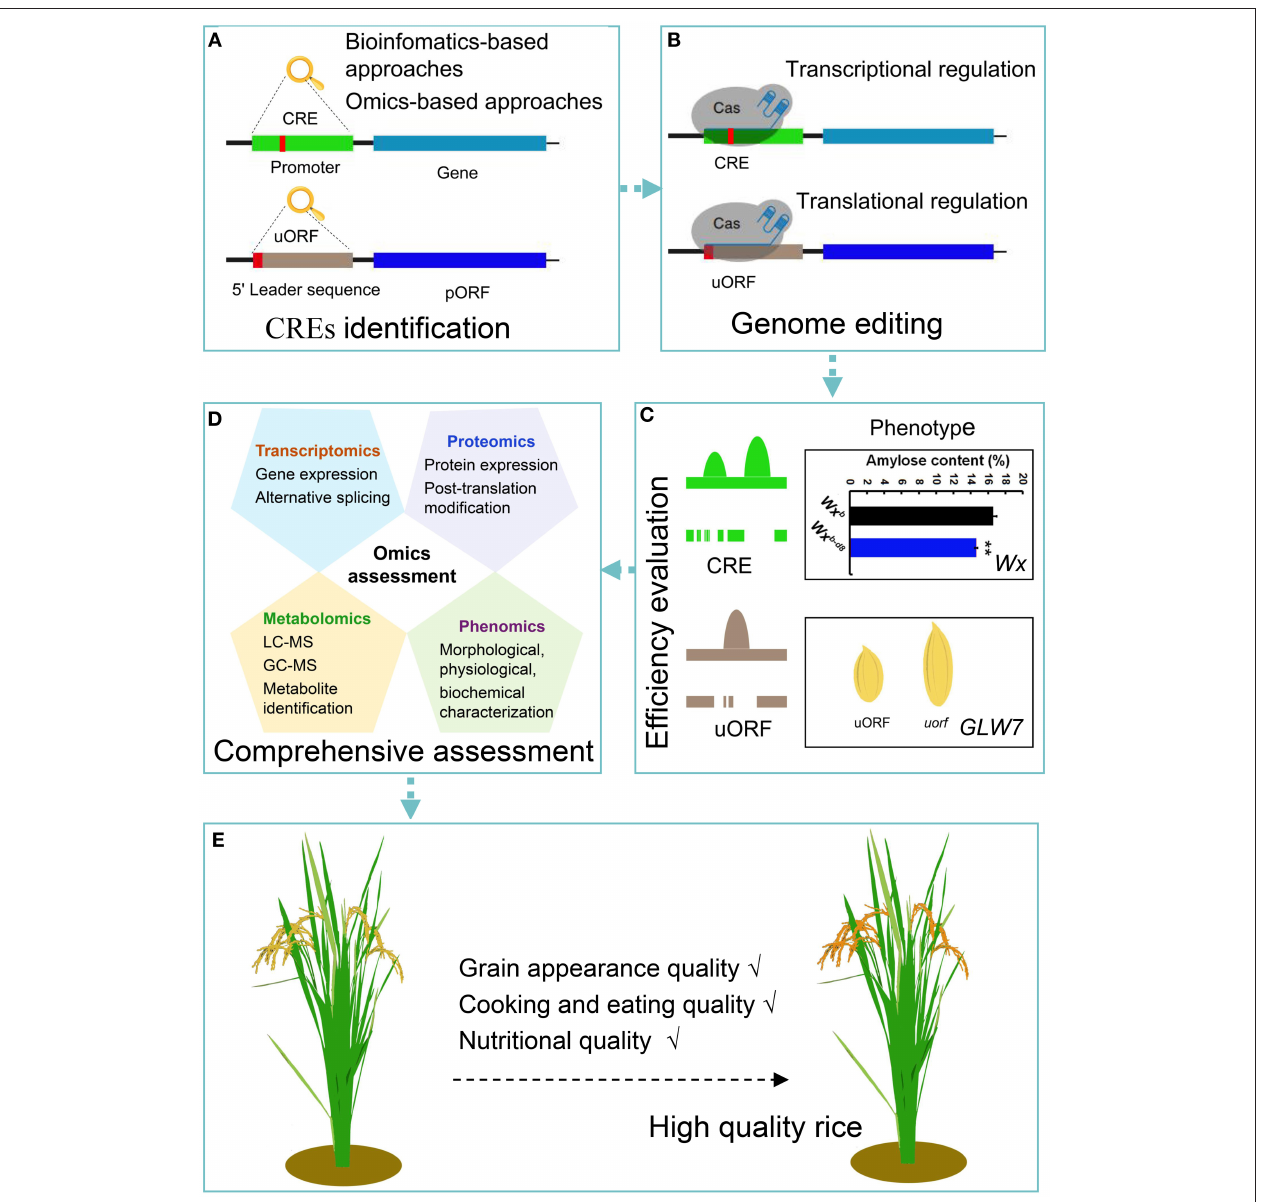
FIGURE 1 | Schematic representation of the workflow depicting the application of genome editing approaches to obtain high grain quality rice. (A) CREs are identified by multiomics strategies and bioinformatic approaches. Cis -regulatory sequences are linear nucleotide fragments of non-coding DNA. Their localization and orientation in relation to genes and activity vary (Verter and Botha, 2010). uORFs, as translational regulatory elements, are located in the 5 ′ leader sequence of eukaryotic mRNAs and generally inhibit the translation initiation of downstream pORFs (Kurihara, 2020). (B) Selection of the desired target DNA sequences of CREs and uORFs, and recognition of PAM sequences for genome editing, which regulates gene expression at the transcription and translation levels, respectively. (C) Efficiency evaluation using molecular identification and phenotypic analysis. For example, a genome editing strategy was used to edit the core promoter region of the Wx gene, and the obtained Wx b − d 8 mutant had a nine nucleotide deletion (Huang et al., 2020a). In the Wx b − d 8 mutant, the predicted core promoter region was disrupted, which decreased Wx expression compared with the wild-type Wx b and reduced the amylose content (%) in the mature rice seeds (Huang et al., 2020a). The same method is applicable to edit the predicted uORF of GLW7 (Si et al., 2016). The deletion of predicted uORF in the GLW7 5 ′ leader sequence causing increased expression levels of the GLW7 protein and enhanced rice grain length. Colored peaks represent different TF-binding events within CREs or uORFs, and peak height indicates the chromatin accessibility from genomic data sets (i.e., DHase-seq and ATAC-seq). Lines with spaces beneath the TF-binding peak indicate destroyed CRE or uORF sequences. (D) Comprehensive assessment of edited rice using multiomics strategies. (E) Obtaining the desired high-quality rice. CRE, Cis -regulatory element; uORF, upstream open reading frame; pORF, primary open reading frame; PAM, protospacer adjacent motif; Wx , the Waxy gene encoding granule-bound starch synthase I, which controls amylose synthesis in rice endosperm; Wx b , Nipponbare carrying the Wx b allele; Wx b − d 8 , the Wxb-d8 mutant with nine nucleotide deletion of the core promoter region in Nipponbare ( Wx b ). GLW7, which is encoding the plant-specific TF OsSPL13, positively regulates cell size in the grain hull, resulting in enhanced rice grain length and yield (Si et al., 2016); TF, transcription